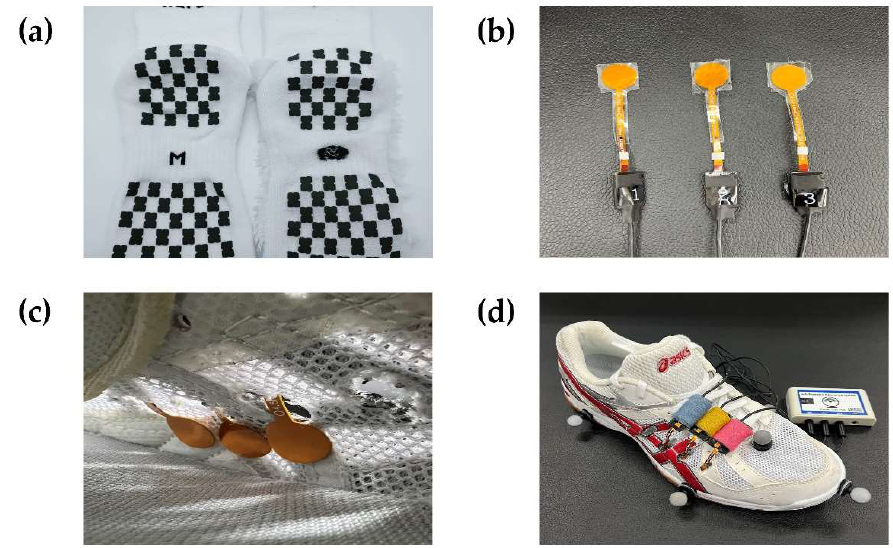
Figure 1. Socks, shoes, and equipment utilized in this study. ( a ) The US socks; ( b ) pressure sensors; ( c ) pressure sensors installed on the inner part of the shoe upper; ( d ) running shoes (Revele-FL5).